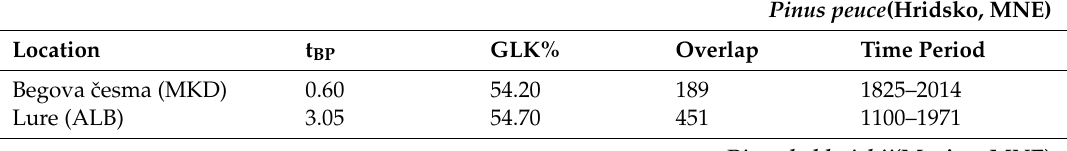
Table 3. Comparison of P. peuce and P. heldreichii chronologies from Montenegro with chronologies for the same species from Bosnia and Herzegovina (BIH), Albania (ALB), Kosovo (XKX), and North Macedonia (MKD). All chronologies for comparison are from the dendrochronological archive of the Slovenian Forestry Institute.